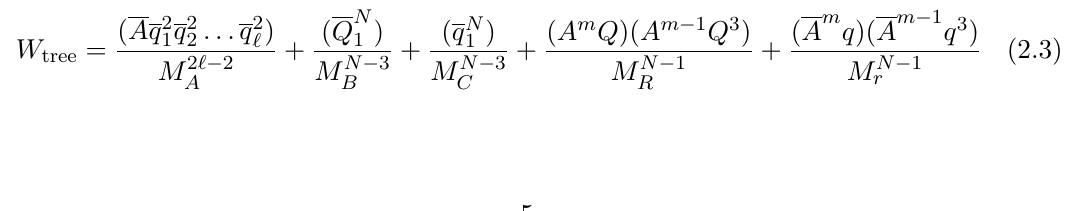
Figure 1 . Moose diagram indicating the matter content and gauge interactions of the SU( N ) ‘ SU(4) SU( N ) r composite axion model. Each G i and (cid:2) SU( N ) (cid:13)avor symmetries are represented by dashed circles. The bifundamental (cid:12)elds Q , Q and q are depicted as directed line segments connecting adjacent groups, while the (cid:12)eld A ( A ) i transforms under G 1 ( G 1 ) in the antisymmetric two-tensor